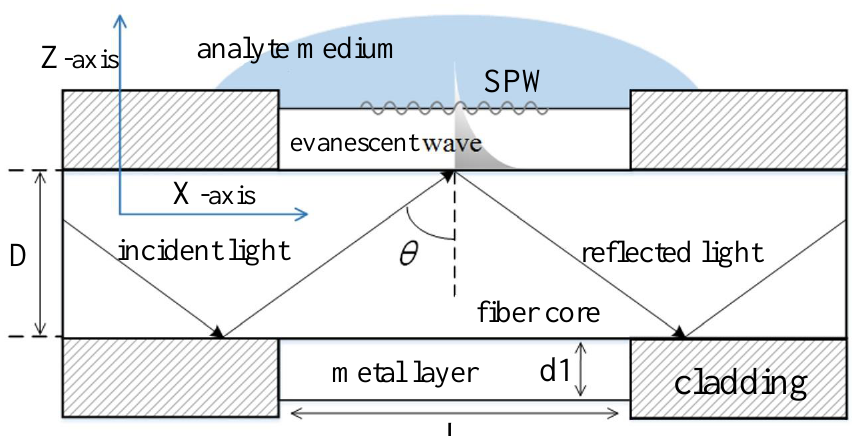
Figure 1. Illustration for SPR-based fiber-optical